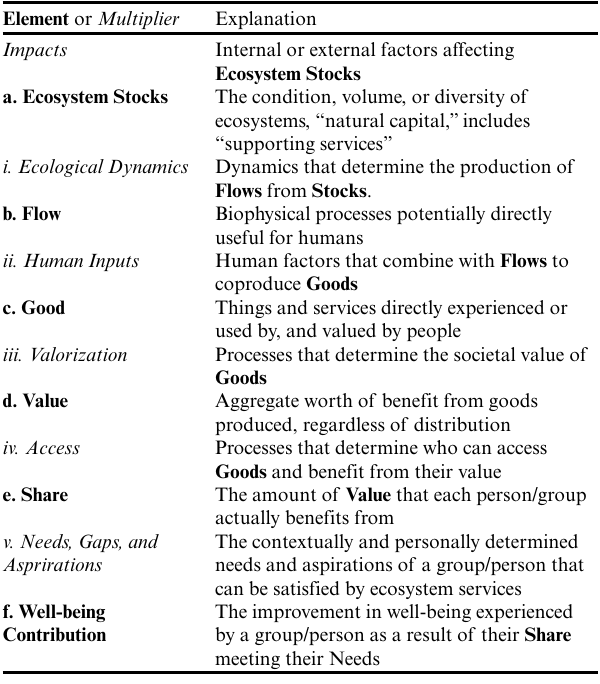
Table 1 . Explanations and examples for the elements and multipliers. For clarity, references to elements and multipliers are formatted as bold and italics, respectively. See Table 2 for